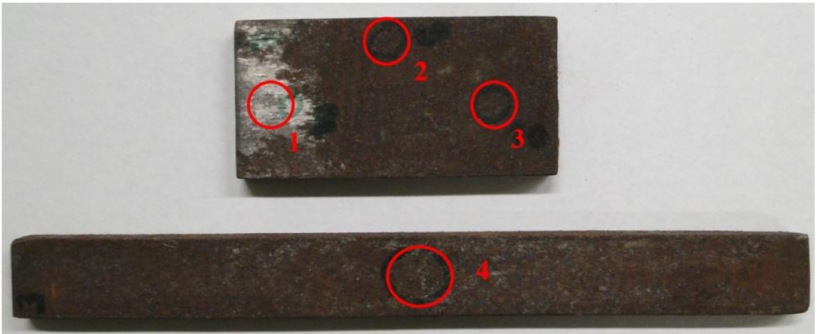
Figure 4. The samples prior to SEM/EDS analysis with indicated analysis